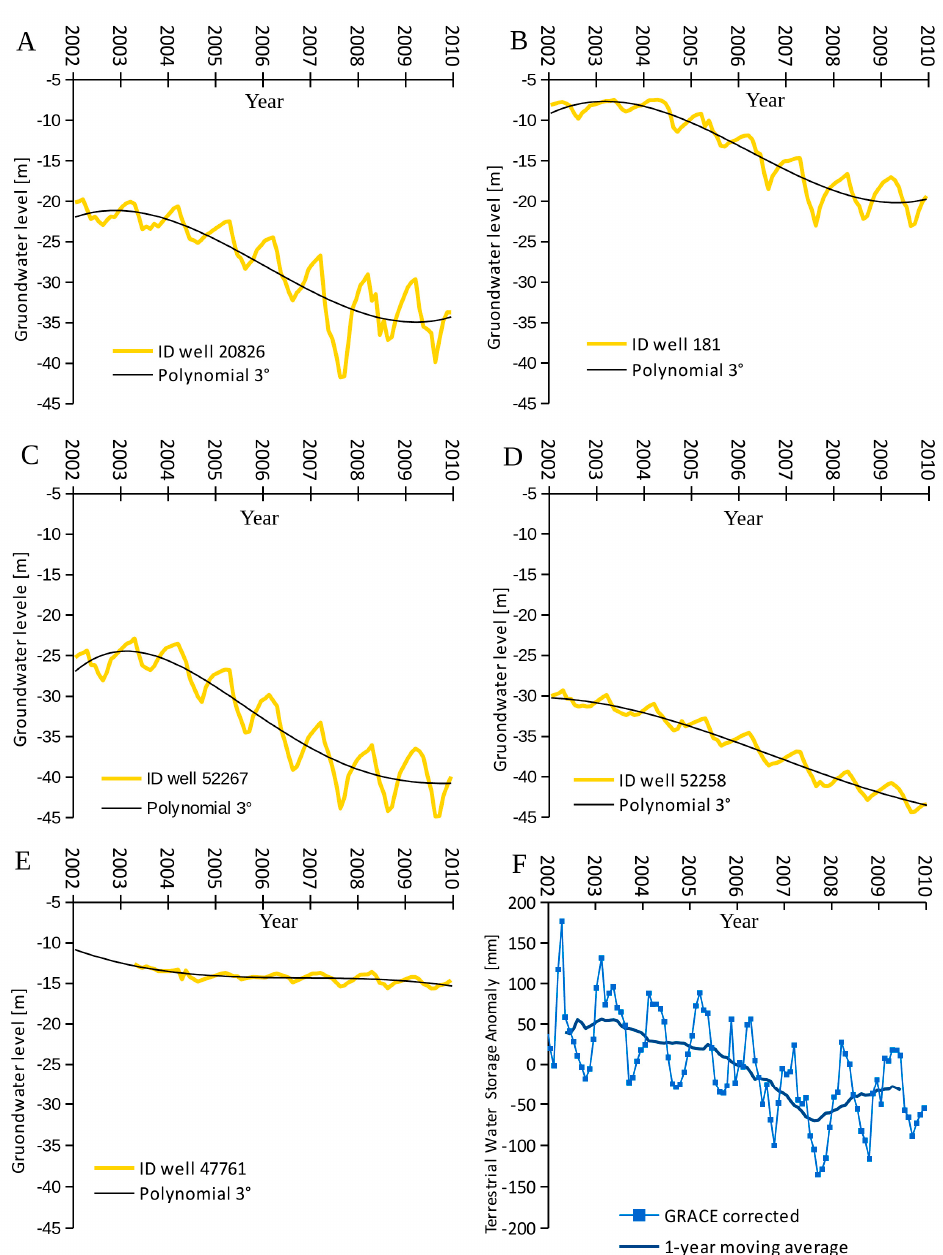
Figure 11. ( A – E ) Groundwater level measured in four wells; ( F ) Water storage anomaly changes derived from GRACE data.